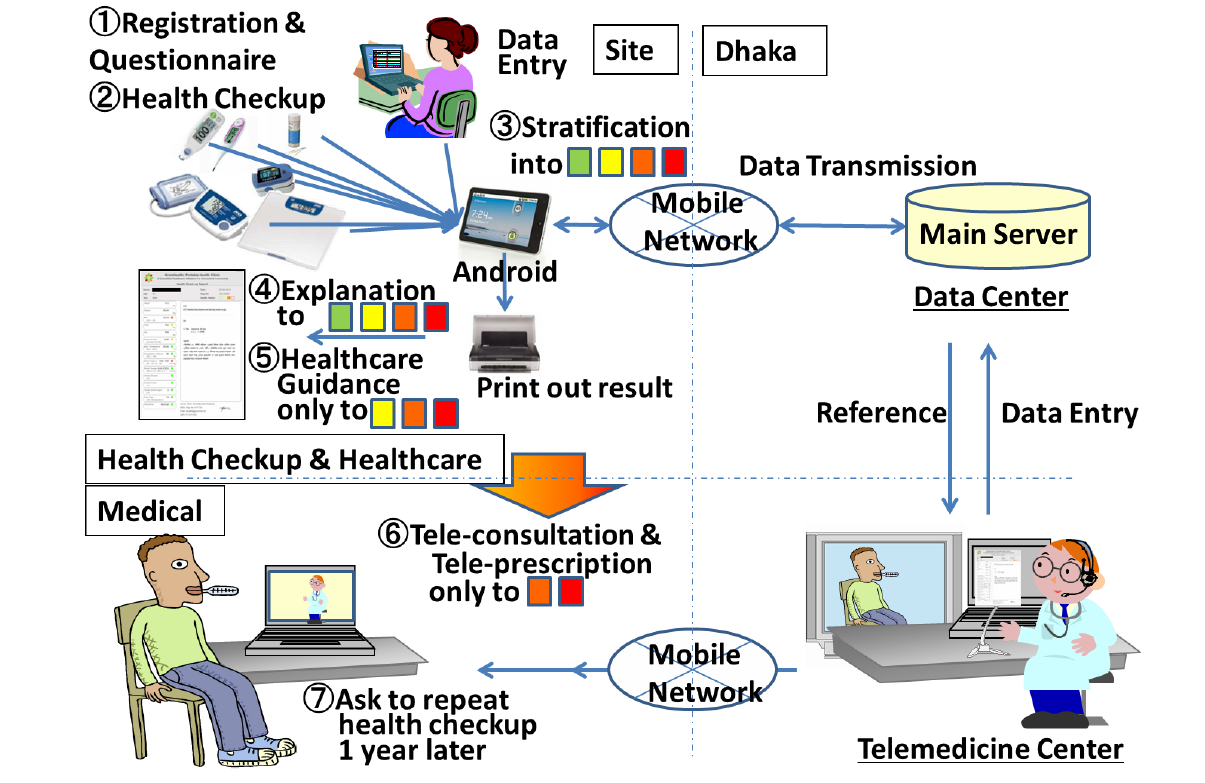
Figure 2. Work flow (Steps 1–7) and data flow (arrows) of the